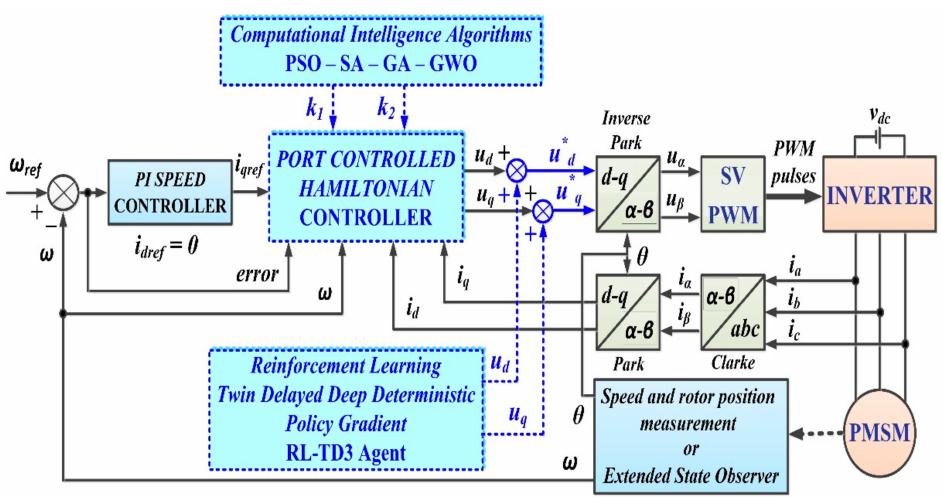
Figure 7. Schematic representation of a nonlinear-type controller: u d and u q